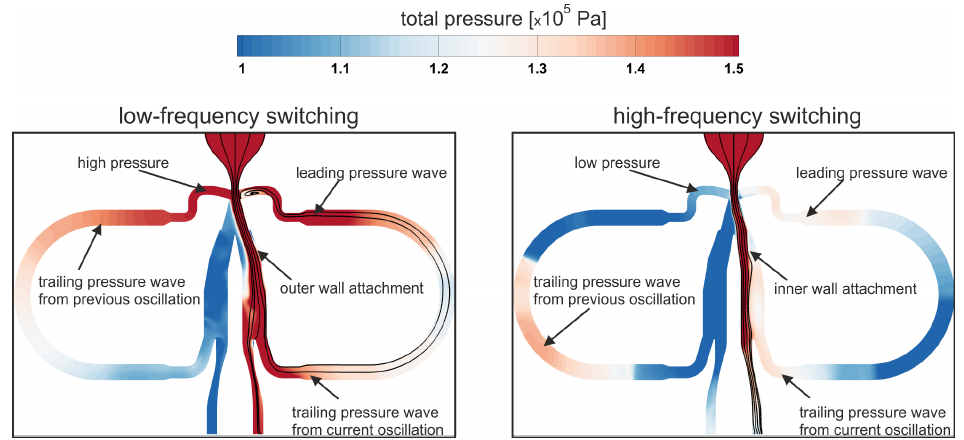
Figure 20. Comparison of the low-frequency switching ( left ) and high-frequency switching ( right ). In the low-frequency case, the pressure at the left control port is higher (1.6 × 10 5 Pa) than the pressure at the right port (1.3 × 10 5 Pa), whereas in the high-frequency case